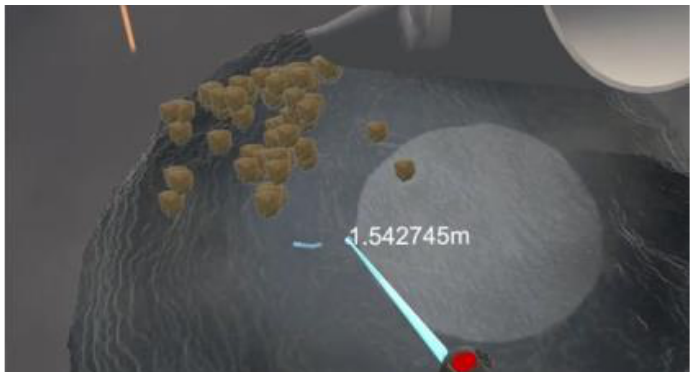
Figure 5. The schematic diagram of material surface depth information acquisition for ironmaking process. The shaders for the highest point are set as accurately 1.542 m for the iron reaction process.